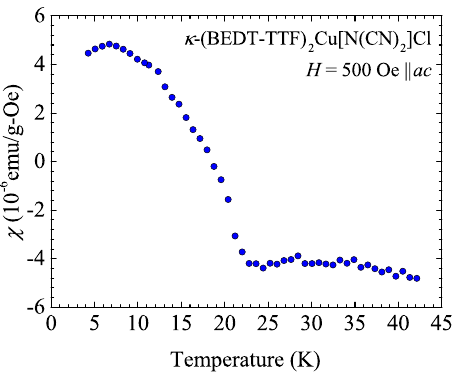
Figure 6. Susceptibility χ of sample S2 of κ -Cl as a function of temperature measured in a magnetic field of 500Oe applied H (cid:107) ac